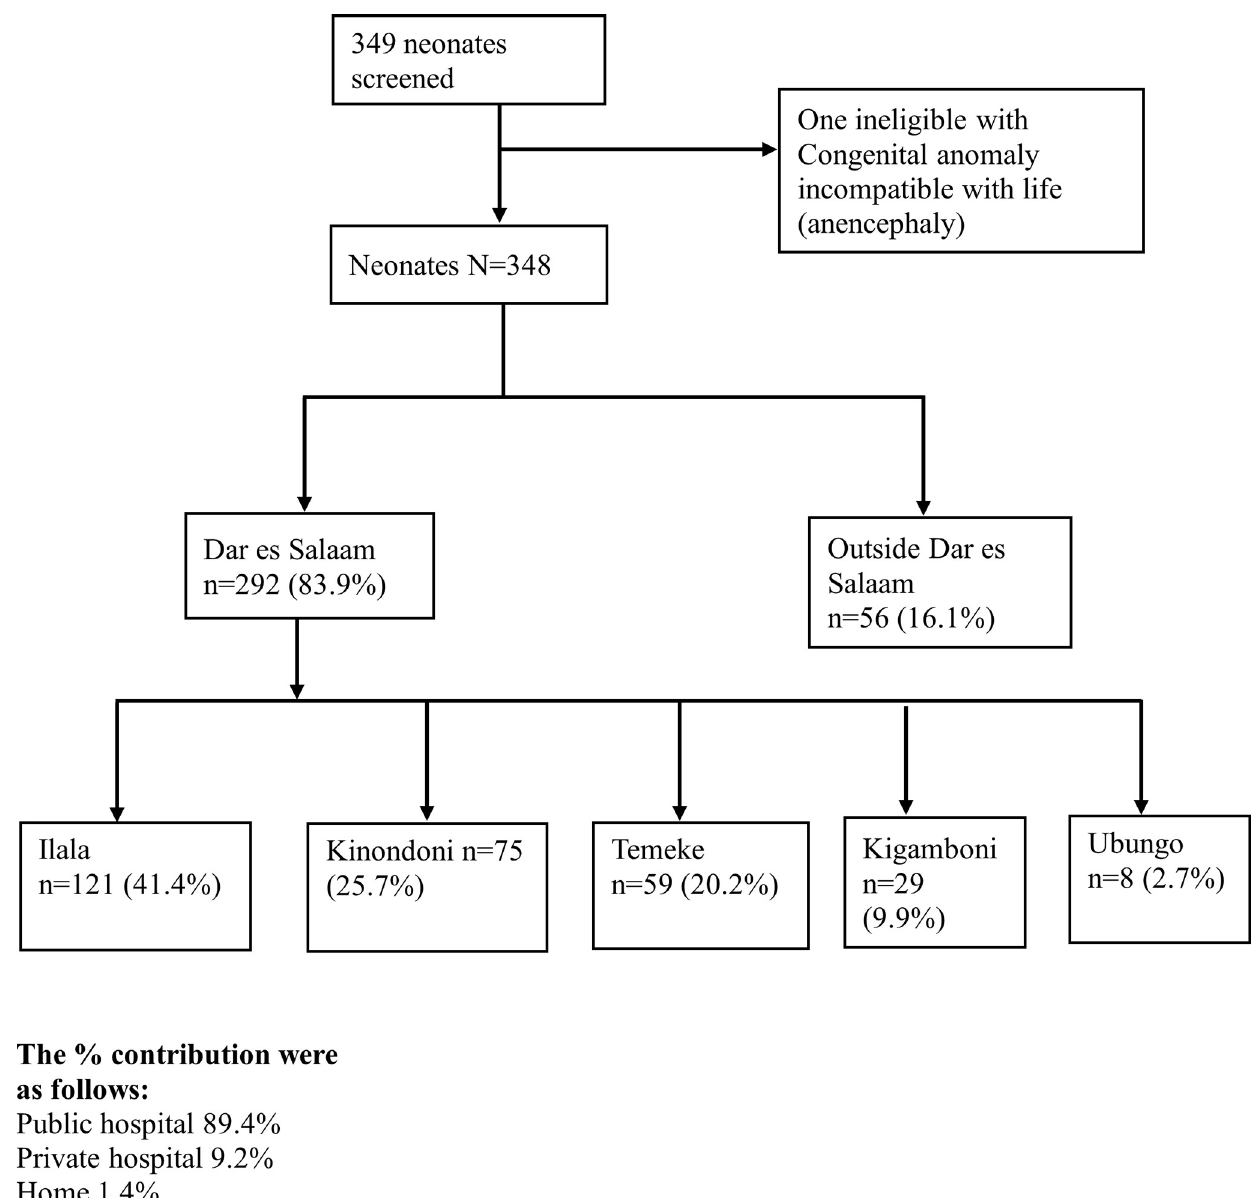
Fig 1. Flow of the study participants referred from various districts of Dar es Salaam, Tanzania.